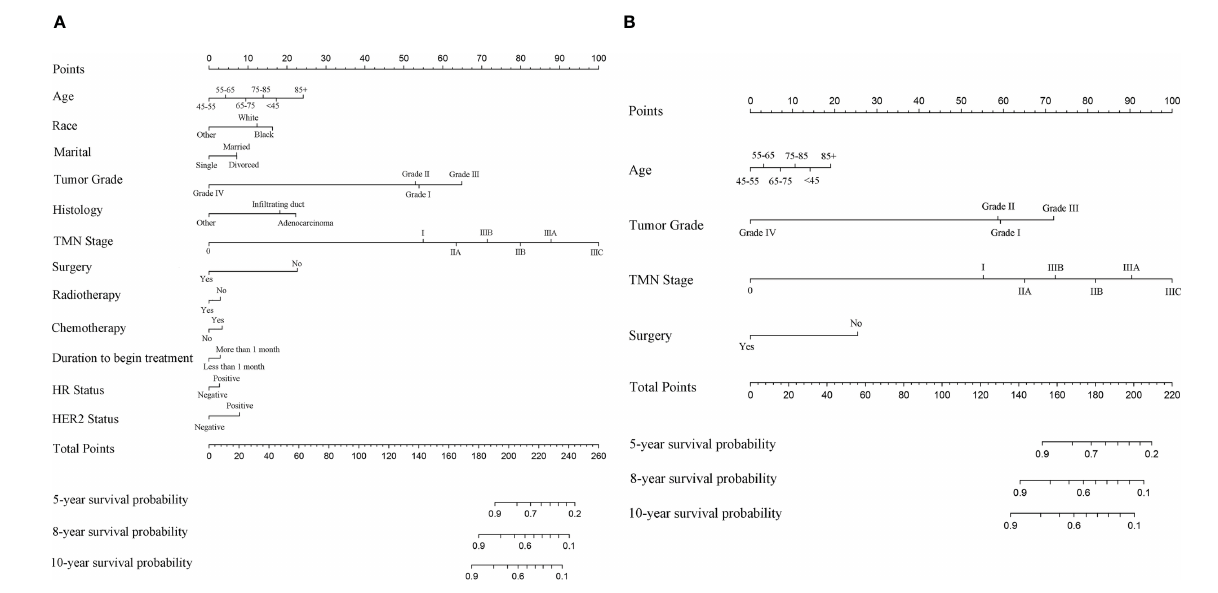
FIGURE 3 (A) The nomogram model 1 to predict the 5-year, 8-year, and 10-year survival probability of MBC patients based on the Fine and Gray method. (B) The nomogram model 2 to predict the same survival probability of MBC patients based on the multivariate Cox regression.